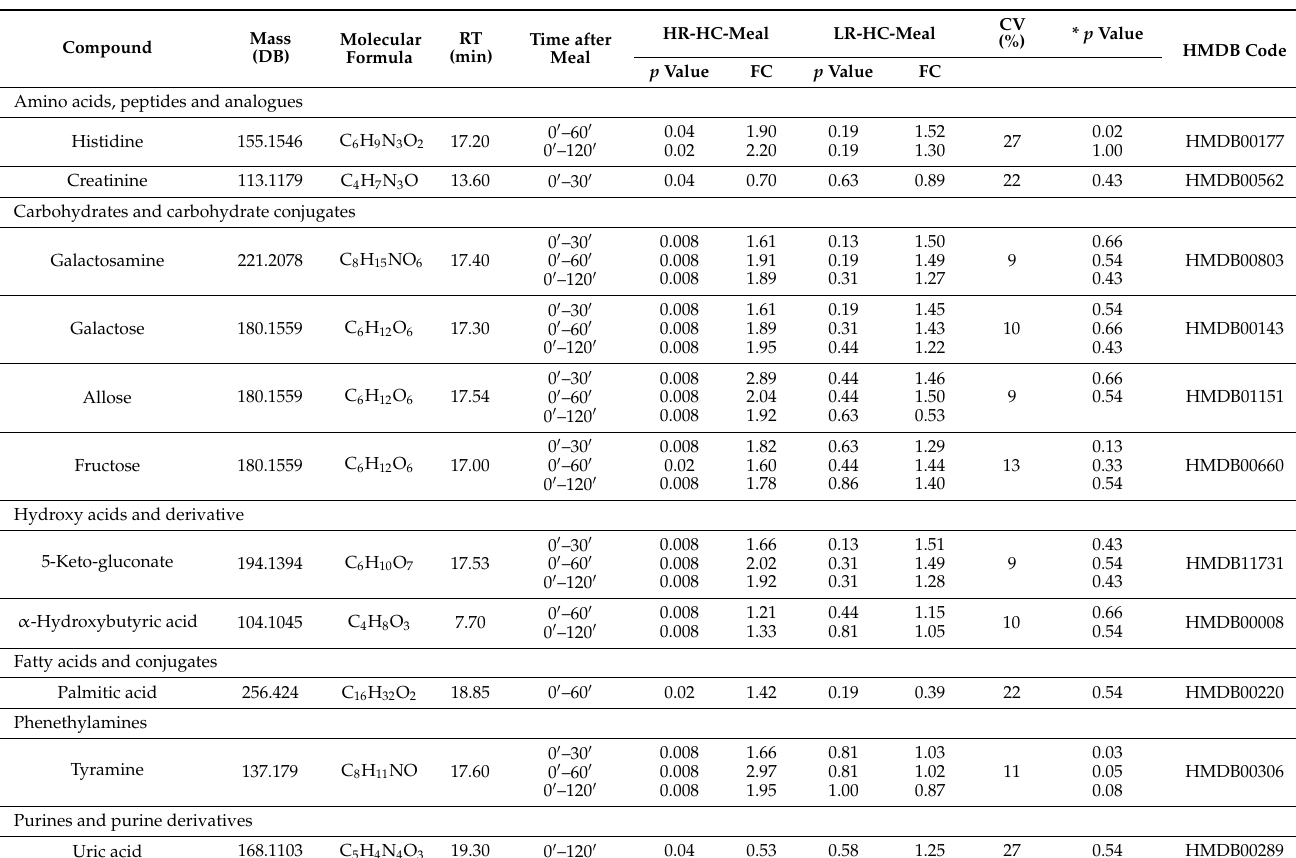
Table 2. The percentage differences in postprandial plasma metabolite levels after HC-meal intake in the PROX1 low- (LR) and high-risk (HR) genotype men. Metabolites that showed statistical significance after Wilcoxon signed-rank test. Mass found in the Human Metabolome Database (HMDB) (http://www.hmdb.caaccessed, on 20 April 2021); RT, retention time expressed in minutes; p value; * p value for between-groups comparison (Mann–Whitney U test); CV, coefficient of variation of the metabolites in the QC samples; FC, fold change in the comparison. Eight individuals from the HR group participated in HC-meal.